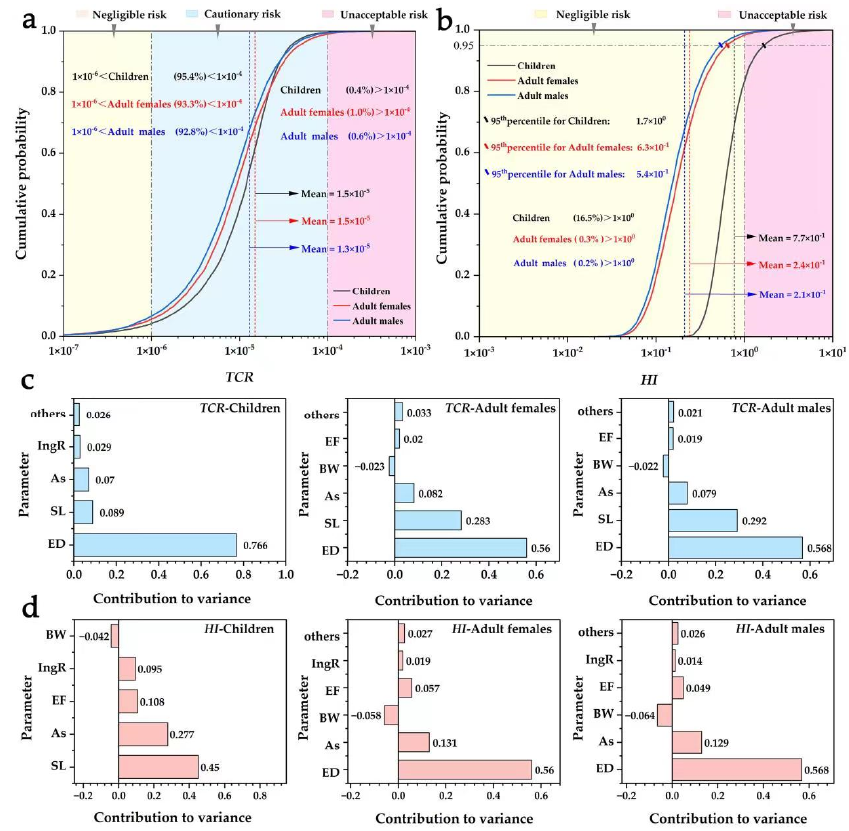
Figure 4. Concentration-based probabilistic health risk estimation results. ( a ) Cumulative probability of TCR ; ( b ) cumulative probability of HI ; ( c ) the sensitivity of TCR ; ( d ) the sensitivity of HI .